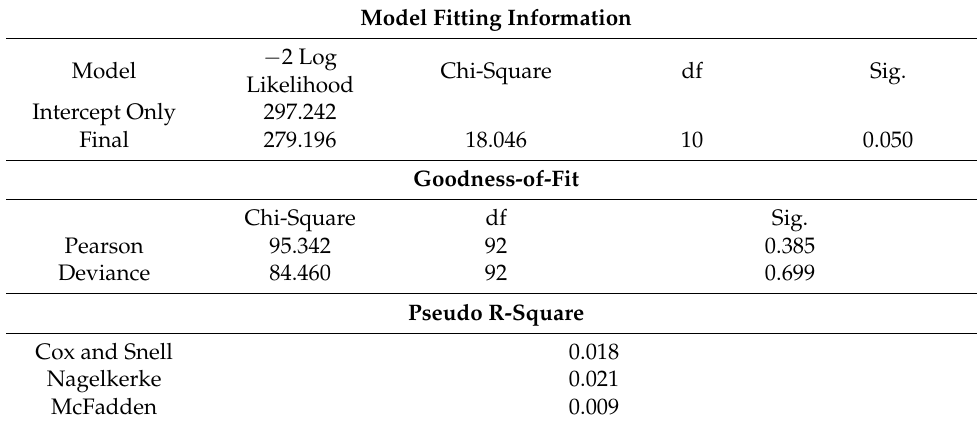
Table 5. Overall fitting indices for the Gender Equality model.